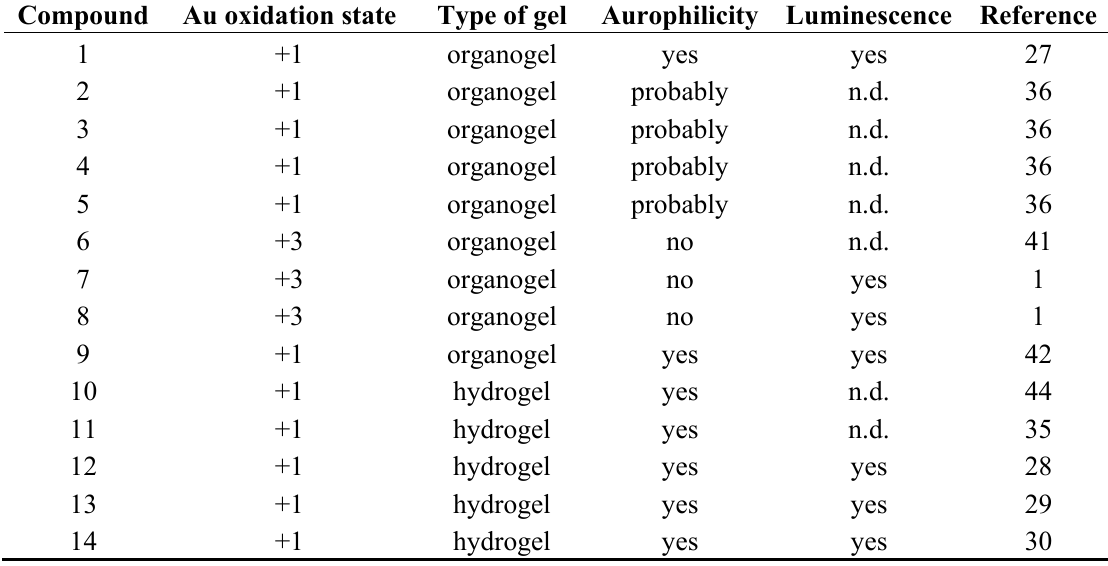
Figure 11. Star-shaped 1-D polymeric structure of 14 showing π-π stacking interactions ( above ). 3- D Crystal packing of Complex 1 viewed down the a- axis displaying a metal-organic framework (MOF)-like motif ( below ). Table 1. Summary of all gold gelators described in this